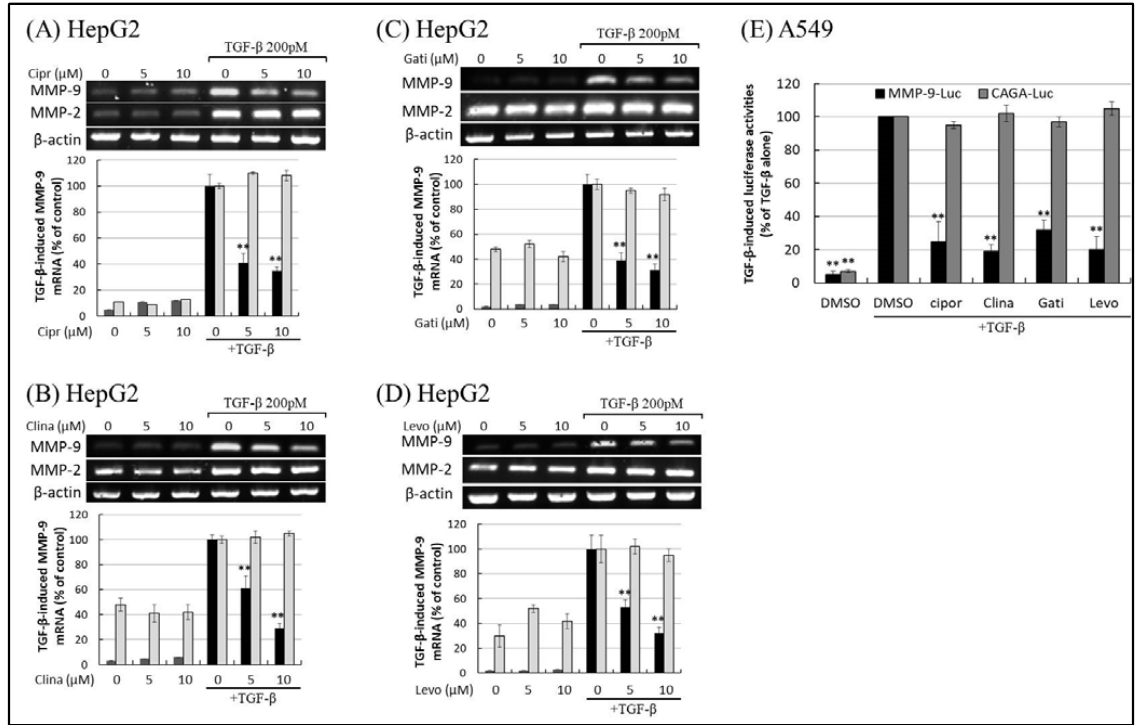
Figure 4. Fluoroquinolones (FQs) inhibit transforming growth factor beta (TGF- β )-induced matrix metalloproteinase-9 (MMP-9) transcriptional activity and gene expression. MMP-9 and MMP-2 gene expression in cells exposed to FQs and TGF- β was detected by reverse transcription polymerase chain reaction (RT-PCR). HepG2 cells were pre-incubated with different concentrations of ciprofloxacin ( A ), clinafloxacin ( B ), gatifloxacin ( C ), and levofloxacin ( D ) for 30 min before stimulation with 200 pM TGF- β . The images shown are representative of three independent experiments with similar results. ( E ) Promoter assays in cells exposed to FQs and TGF- β , similar to RT-PCR. Firefly and renilla luciferase activity were measured in cells co-transfected with MMP-9-Luc, CAGA-Luc, and pRL-CMV and incubated in the presence or absence of FQs and TGF- β . MMP-9 and CAGA firefly luciferase activity was normalized to renilla luciferase activity, and the intensity of the luciferase signal in the treatment groups was expressed as a percentage of that measured in the TGF- β -stimulated experiments. Results are presented as means ± standard deviation (error bars) of three independent experiments. Statistically significant differences (** p ≤ 0.001) were observed between cells treated with TGF- β -stimulated controls and those treated with TGF- β and FQs.